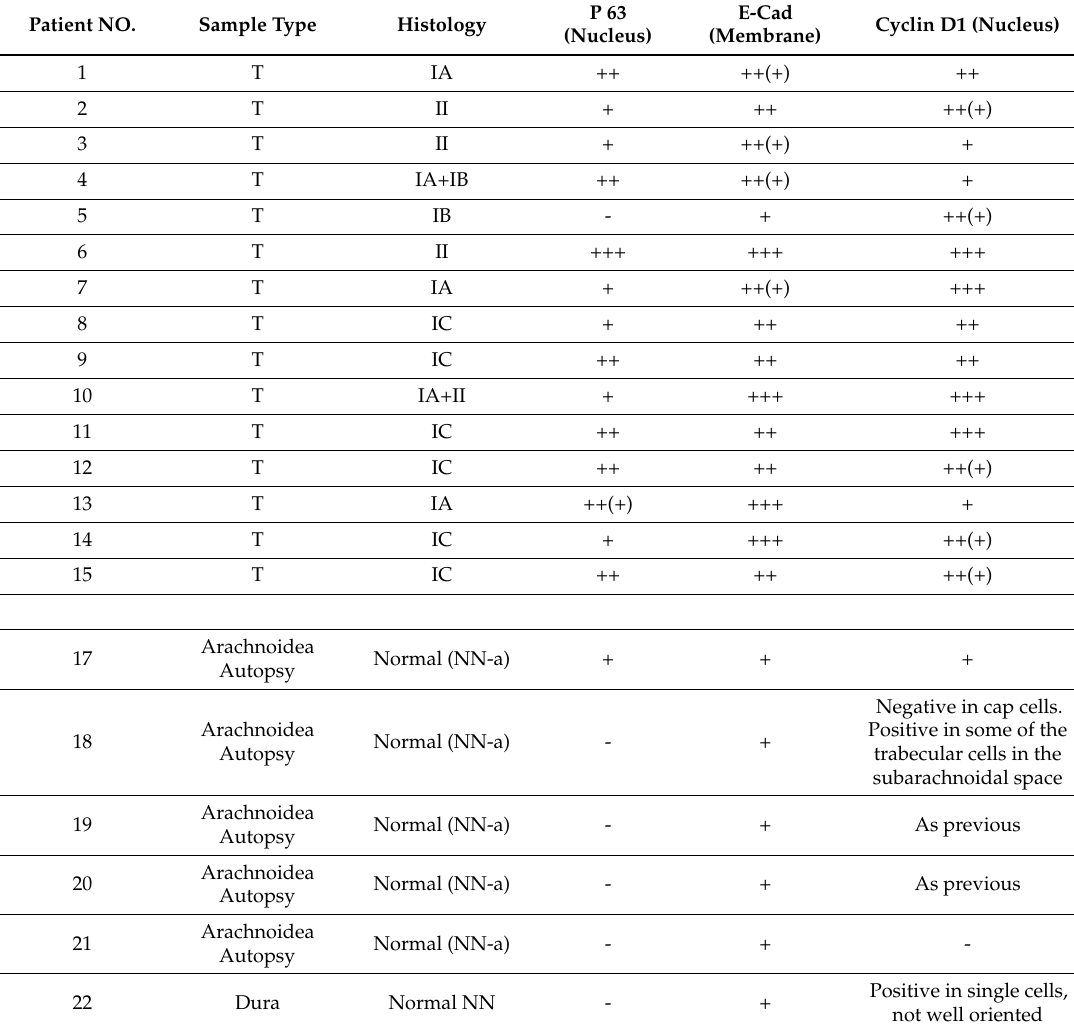
Table 5. Immunohistochemistry of p63, E-Cadherin and Cyclin D1 of meningioma (grades I and II), and biopsies of dura and arachnoid autopsies of non-meningioma patients. See Table 1. Patient